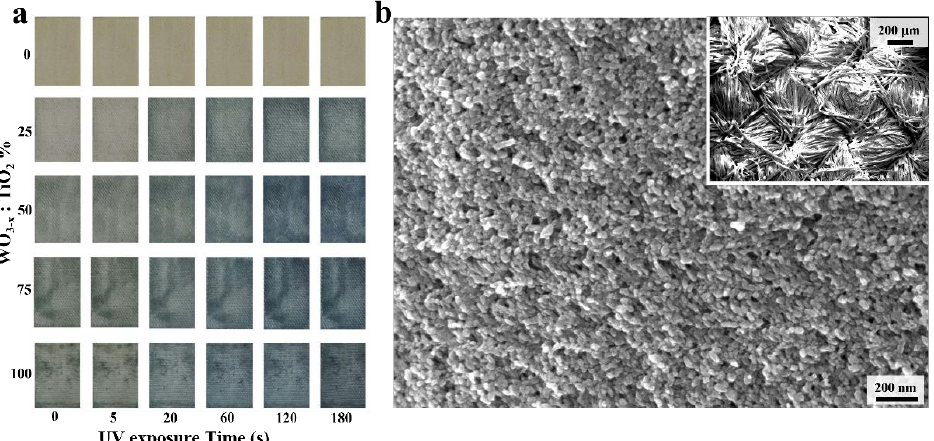
Figure 2. ( a ) Pictures recorded on textile samples functionalized via NC solution impregnation with different WO 3-x :TiO 2 contents; different degrees of blue are obtained with different UV exposure times for each composition. ( b ) Lower (inset) and higher magnification SEM micrograph of textiles functionalized with NC solution prepared with WO 3-x :TiO 2 ratio of 1:3 or 25%.